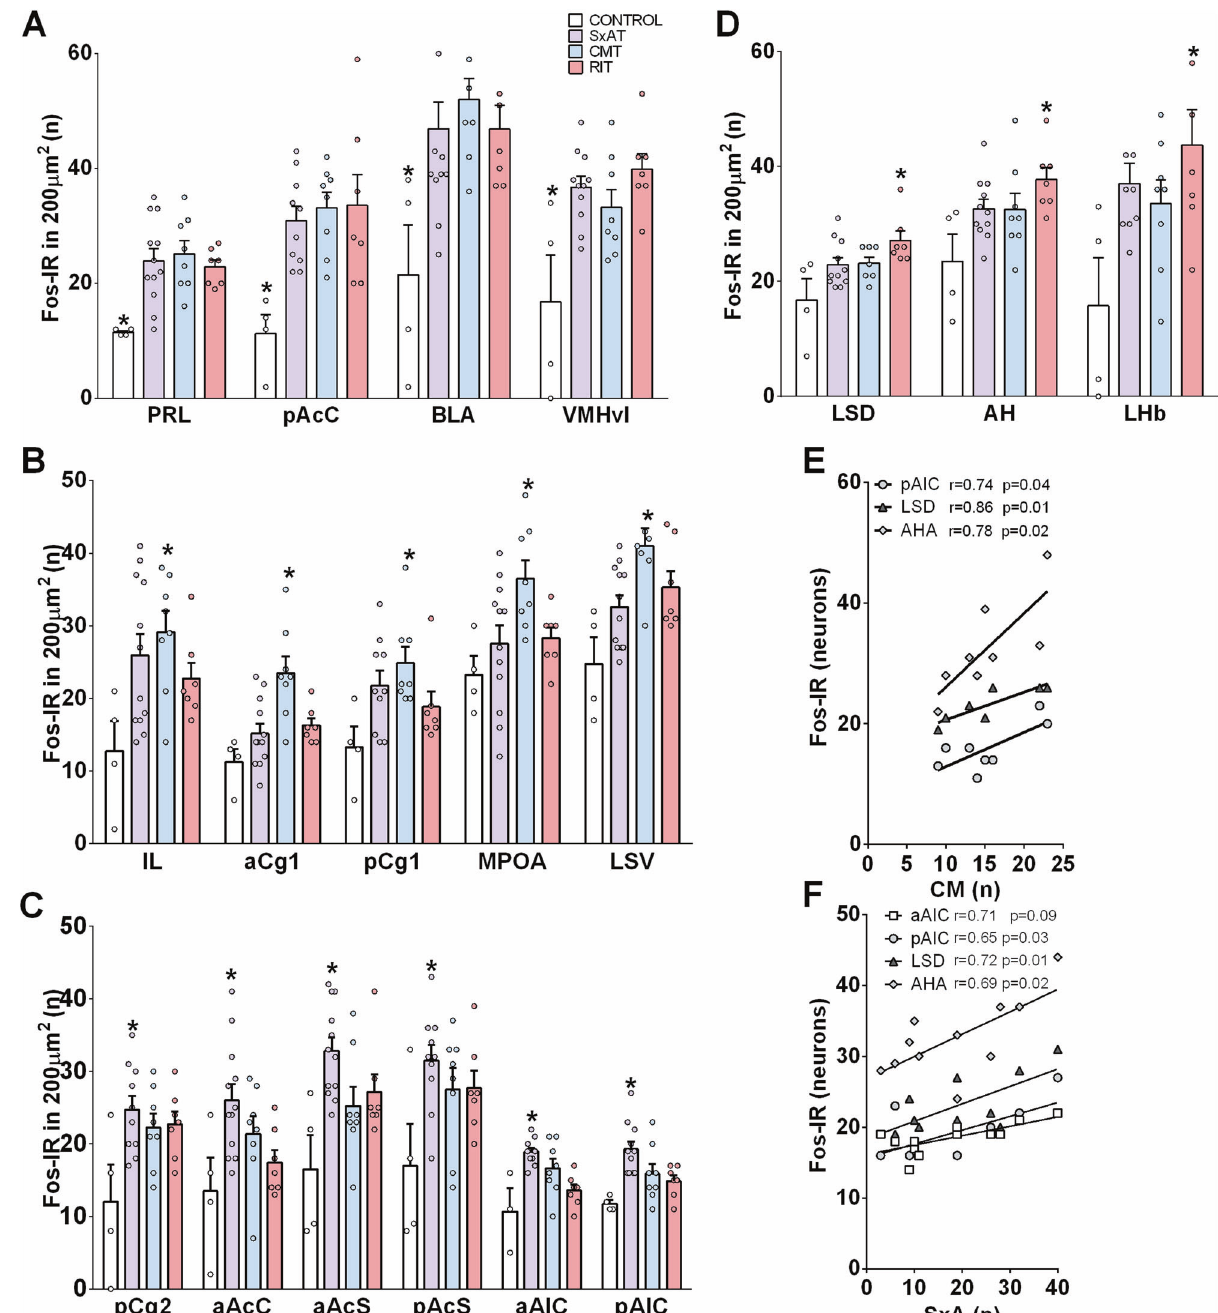
Fig. 4 Neuronal activity in selected brain regions in response to sexual aggression. Neuronal activity was indicated by the number of Fos-IR neurons in response to 10 min of rest (CONTROL) or of exposure to the sexual aggression test (SxAT, purple bars), consensual mating (CMT, blue bars) or resident-intruder test (RIT, red bars). Brain areas are grouped according to activation patterns: A regions activated in all conditions, B regions activated exclusively by CMT, C regions activated only during the SxAT, and D regions activated only during the RIT. Data are presented as mean + s.e.m.; * p < 0.05 vs. CONTROL. Scatter plots of the number of consensual mounts (CM) in the CMT ( E ), or of aggressive behavior ( F ) in the SxAT vs. the number of Fos-IR in the aAIC, pAIC, LSD, and AHA. PRL pre-limbic cortex, IL infra-limbic cortex, aCg1 anterior cingulate cortex 1, pCg1 and pCg2 posterior cingulate cortex 1 and 2, respectively, aAIC and pAIC anterior and posterior agranular insular cortex, respectively, aAcC and pAcC anterior and posterior nucleus accumbens core, respectively, aAcS and pAcS anterior and posterior nucleus accumbens shell, BLA basolateral amygdala, CeA central amygdala, MeApd posterodorsal medial amygdala, LSD dorsal lateral septum, LSV ventral lateral septum, AH anterior hypothalamic attack area, LHA lateral hypothalamic attack area, LHb lateral habenula, MPOA medial preoptic area, VMHvl ventrolateral ventromedial